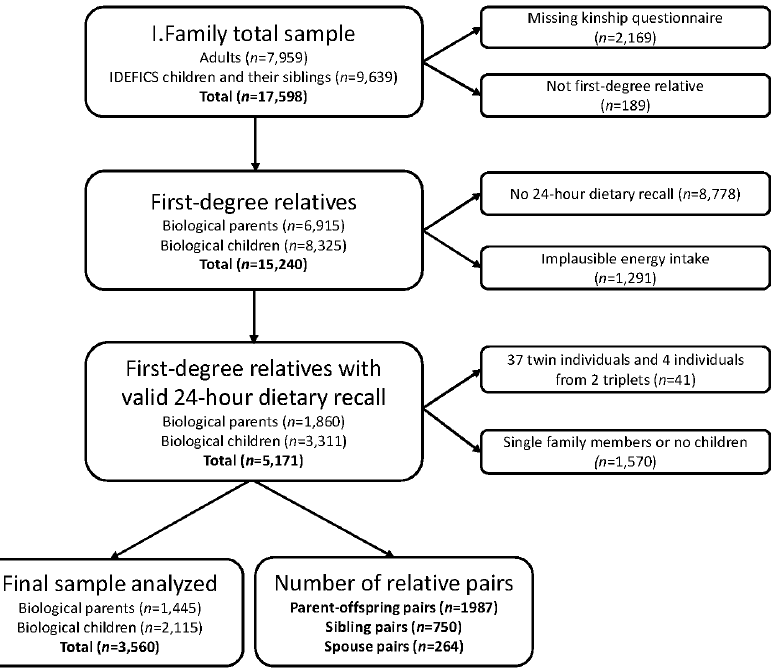
Figure 1. Flowchart showing the process leading to the final sample analyzed.